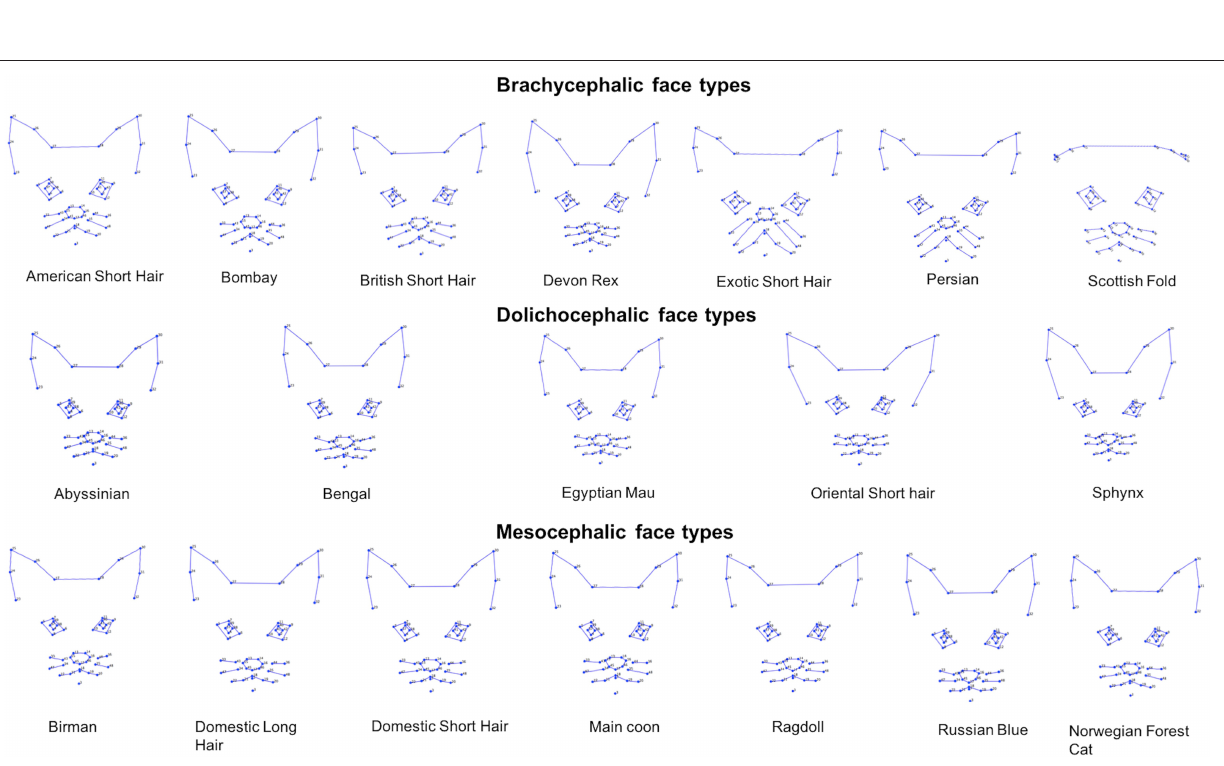
Frontiers in Veterinary Science |